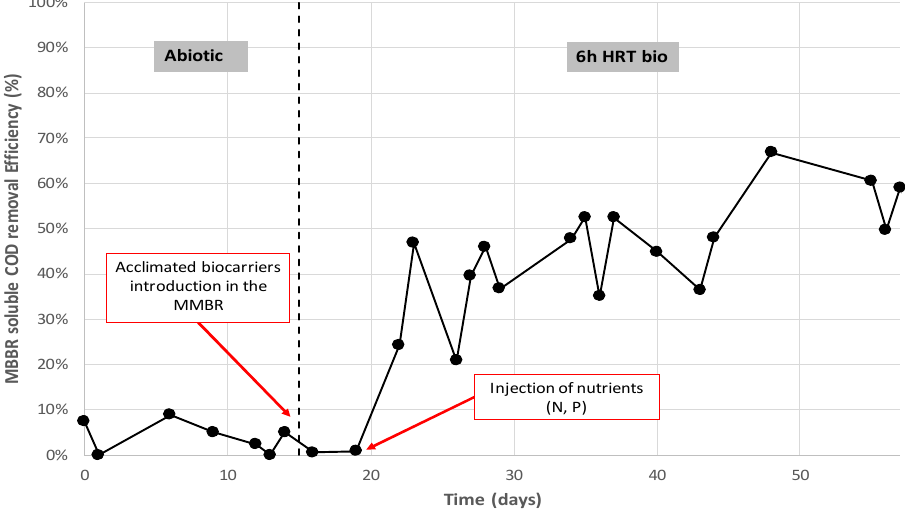
Figure 9. Soluble COD removal during the abiotic phase and after introduction of acclimated bio- carriers.